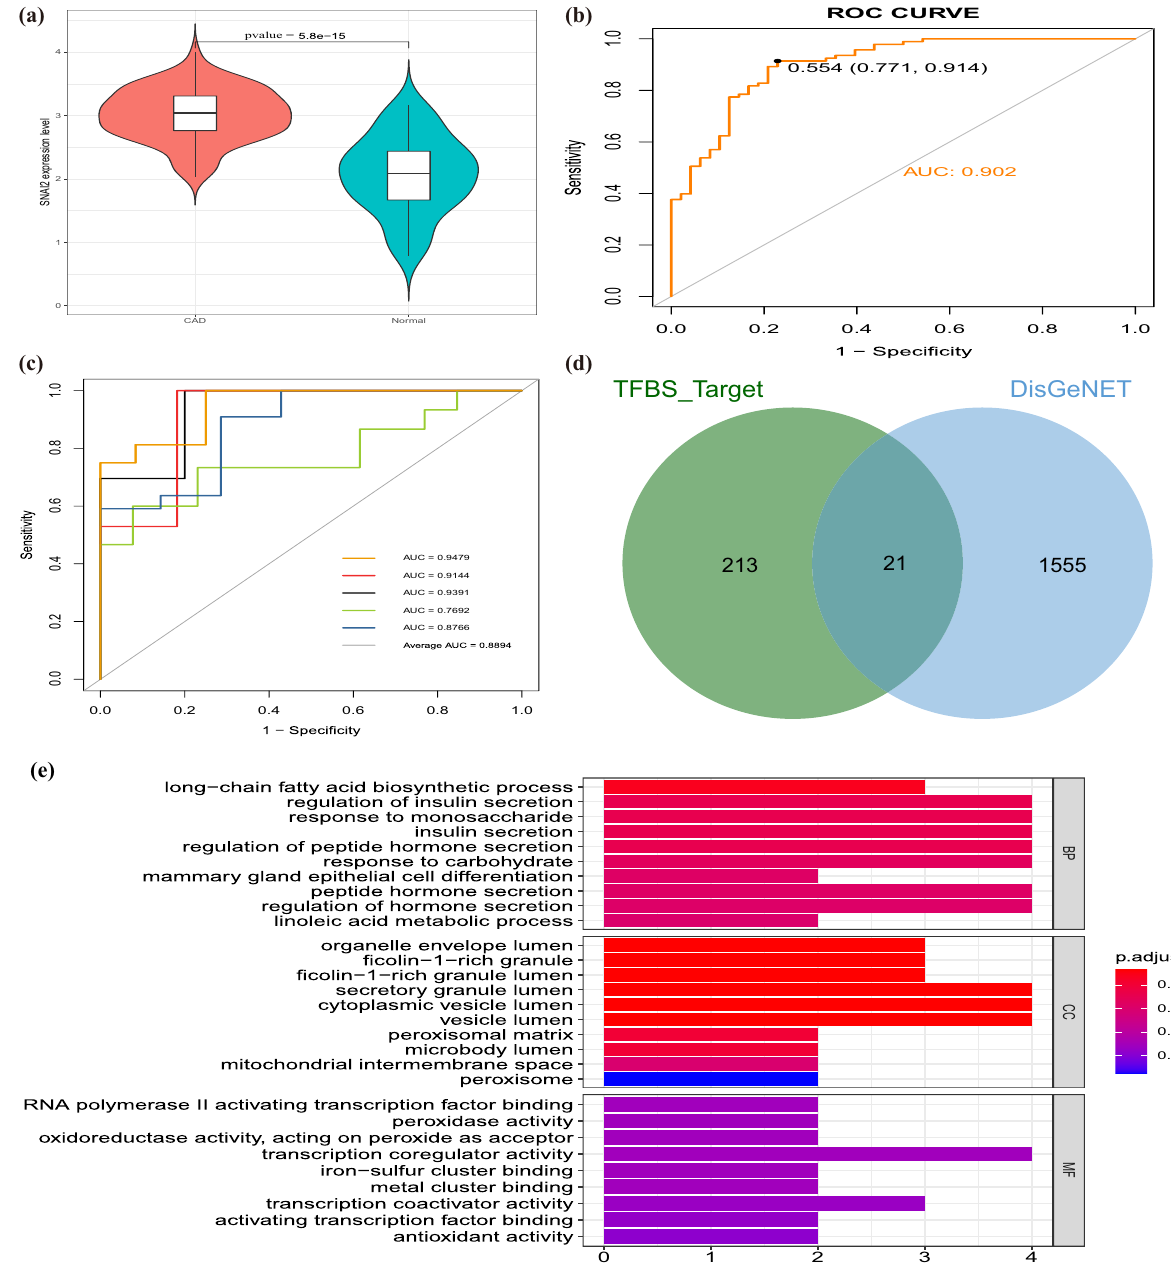
Figure 5: Clinical performance of SNAI2 in CAD. ( a ) SNAI2 is highly expressed in CAD groups and low in normal groups. ( b ) ROC analysis results for SNAI2 in CAD. ( c ) The ROC curve of predicted outcomes of SNAI2 diagnostic signature by a logistic regression model. ( d ) Venn diagram of 21 CAD - related genes regulated by SNAI2. ( e ) GO enrichment analysis of 21 CAD - related genes regulated by